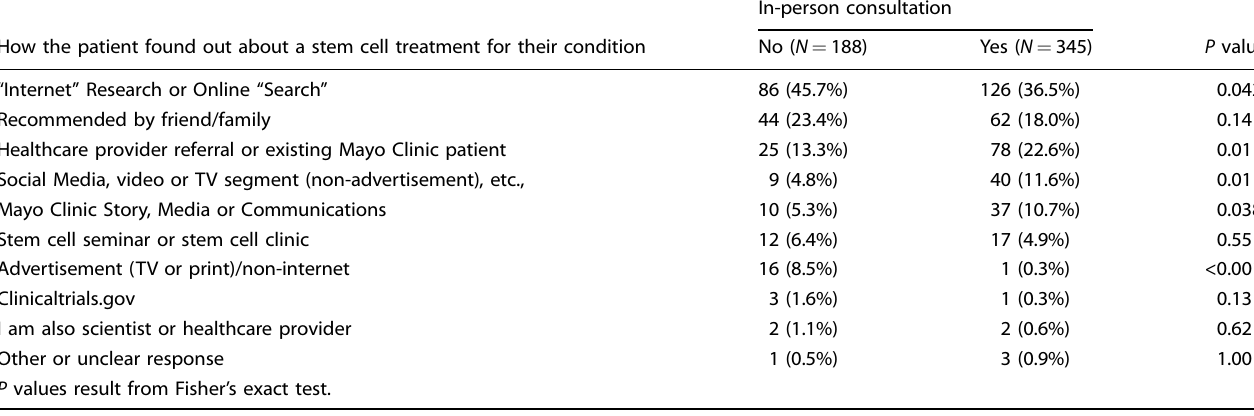
Table 4. Comparison of responses for how patients found out about a SCT for their condition according to whether they had an in-person consultation.